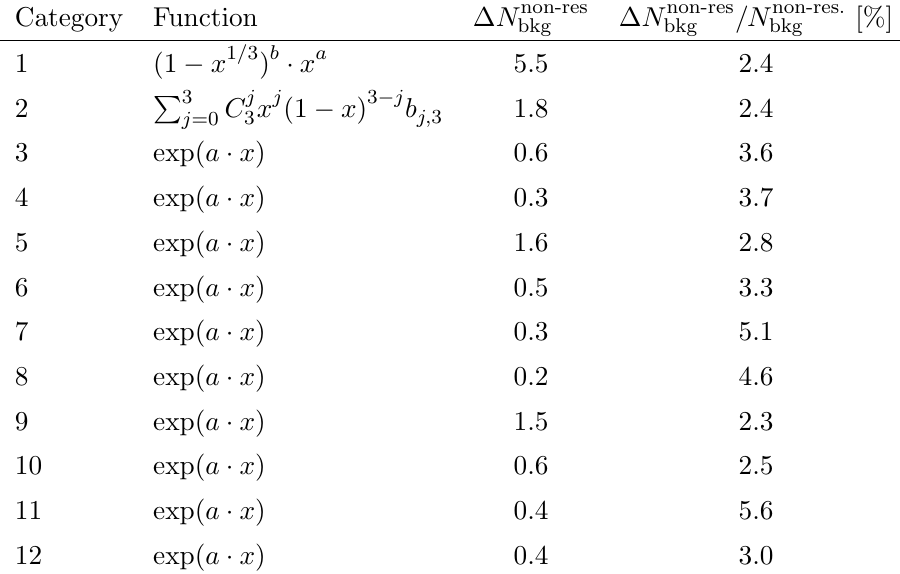
Table 2 . The analytic functions used to model the non-resonant background, the extracted signals from the background-only (cid:12)ts ((cid:1) N non-res ) to the MC and the relative uncertainty in the non- bkg resonant background within 120 < m (cid:13)(cid:13) < 130 GeV ((cid:1) N non-res =N non-res. ) for each category. The bkg bkg p variable x is de(cid:12)ned as m (cid:13)(cid:13) = s while a and b are parameters of the background functions. The C j are binomial coe(cid:14)cients and the b j; are the (cid:12)tted parameters for the third order Bernstein 3 3 polynomial